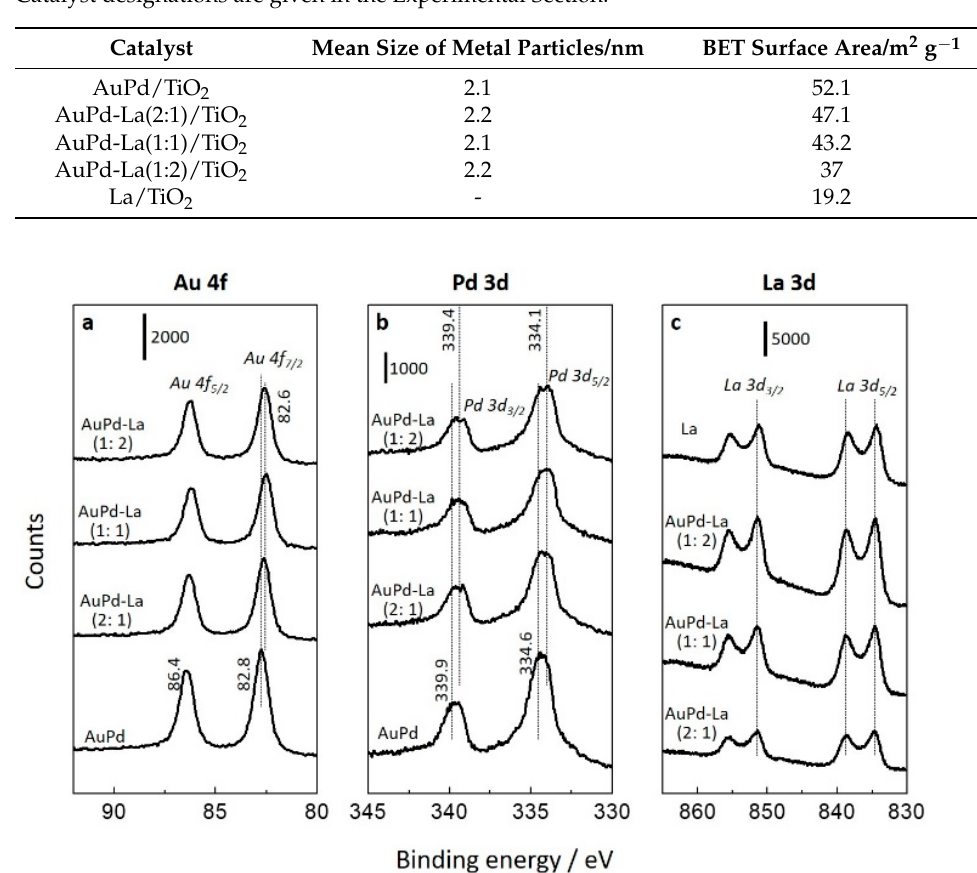
Figure 3. XPS spectra of ( a ) Au 4f, ( b ) Pd 3d, and ( c ) La 3d regions.